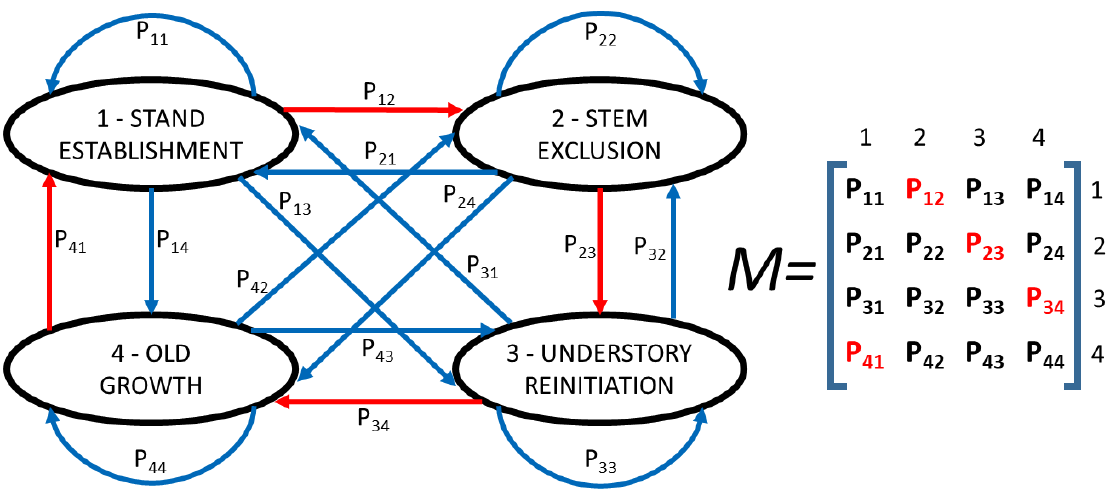
Figure 1. Diagram of a hypothetical Markov Chain model simulating forest stand dynamics. Black ovals represent four phases in stand dynamic in which the forest can be at a given moment. Blue and red arrows show the possible transitions between states. The probability of each transition is denoted as P ij , being i the present stage and j the future stage. All the probabilities together create M (the transition matrix). In a deterministic (Clementisan) model, all the probabilities in red (corresponding to transitions marked by red arrows) have a value of one, and the rest a value of zero.